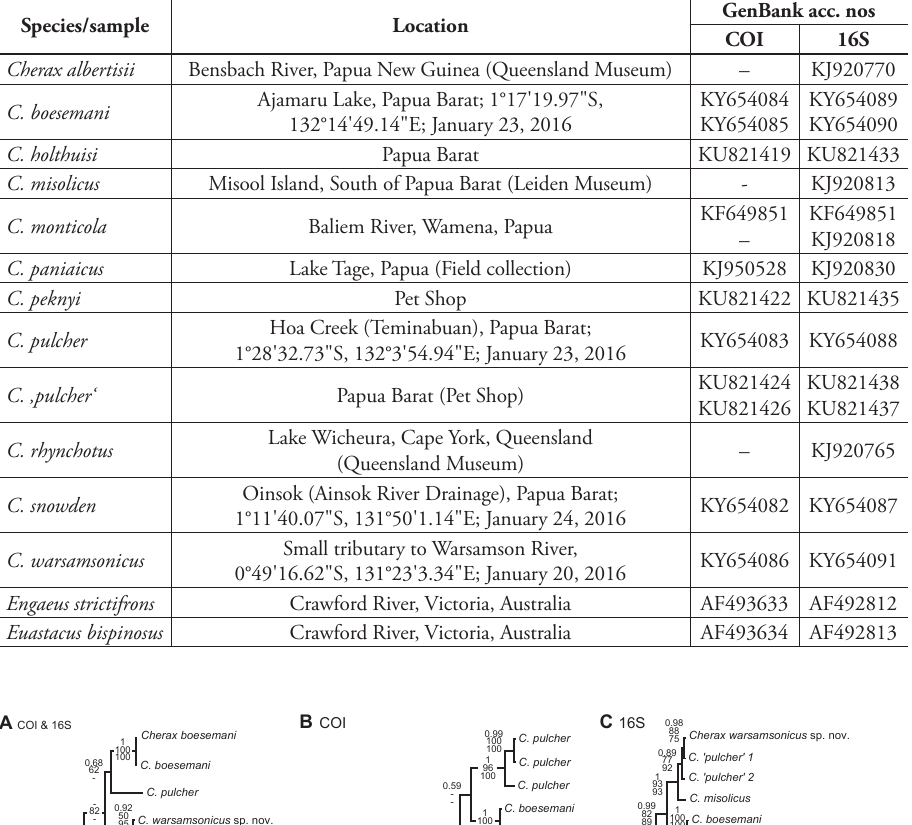
Table 1. Material studied with GenBank accession numbers.